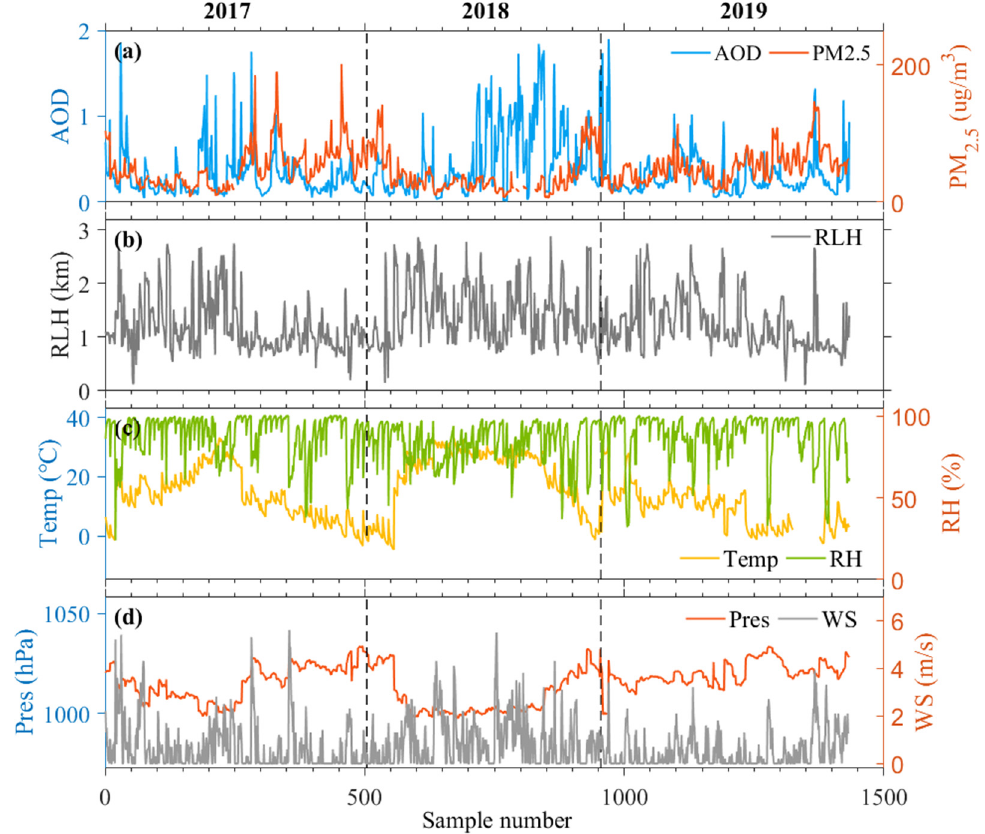
Figure 3. Hourly mean variations of ( a ) AOD, PM 2.5 ; ( b ) RLH; ( c ) Temp, RH; and ( d ) Pres and WS, from January 2017 to December 2019.